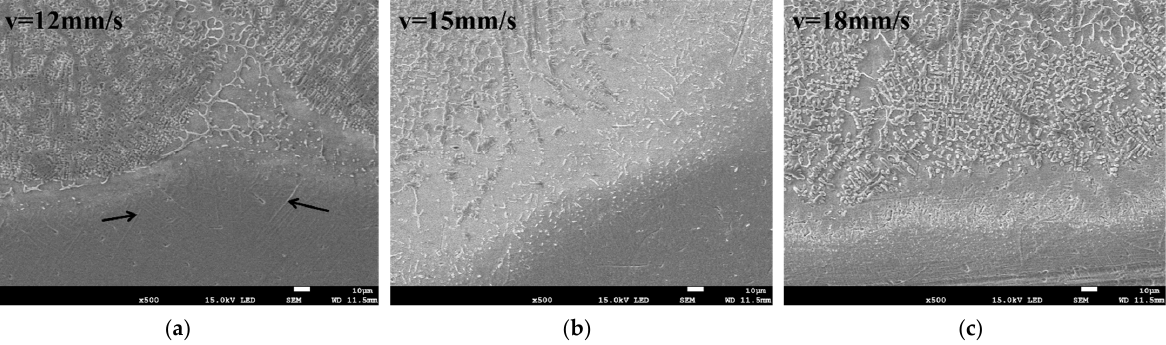
Figure 5. Morphologies of the bonding zone of coatings under different laser scanning speeds.